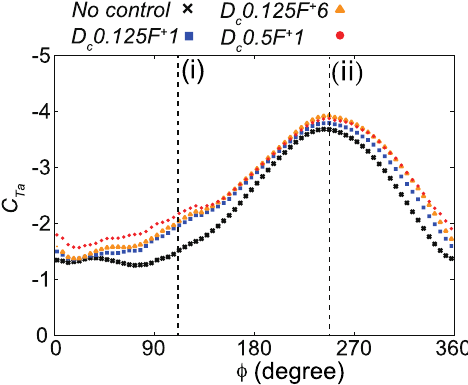
Figure 6. Phase-averaged axial torque coefficient C Ta as a function of the azimuth angle φ